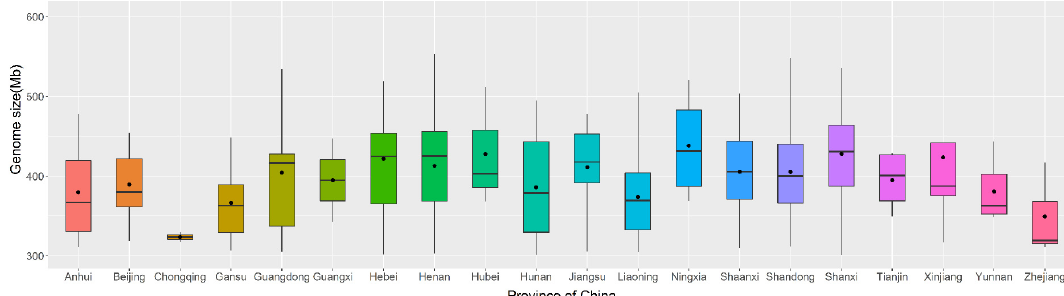
Figure 3. Boxplot of genome size variations of Chinese jujube in different provinces. The horizontal black line within each bar represents the median value of the genome size in a province, while a black dot within the bar denotes the average value of genome size in a province.